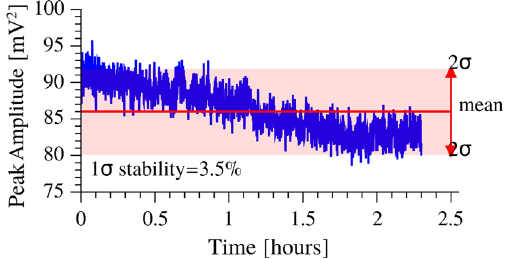
Fig. 7 Stability of the hybrid mode, measured through the amplitude of a calibration peak injected with SO (see text for further details)